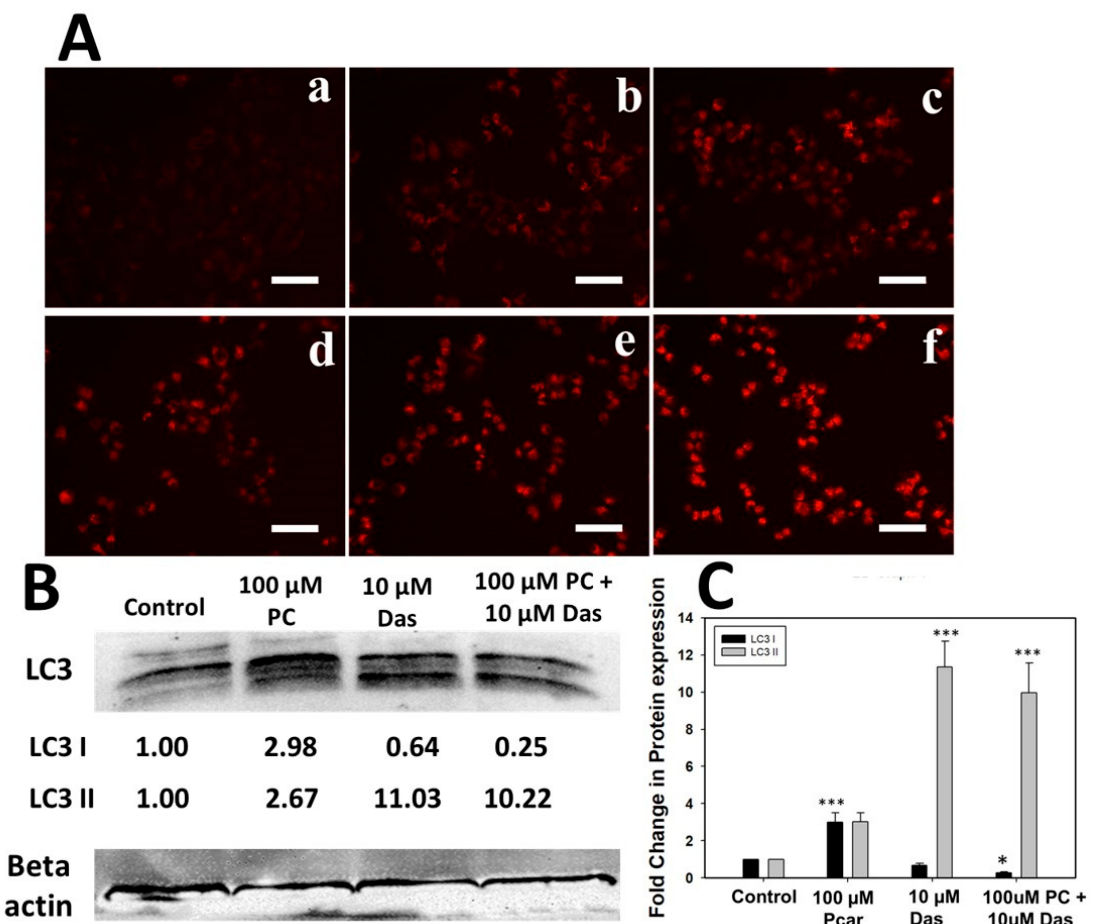
Figure 6. Lysotracker accumulation in HepG2 cells. ( A ) Pcar and Das combined effect showed more Lysotracker accumulation in lysosomes, thus confirming the autophagy induction. ( B ) Expression analysis of LC3 protein. ( a ) Control; ( b ) 100 µM Pcar; ( c , d ) 10 and 20 µM Das; ( e , f ) 100 µM Pcar + 10 and 20 µM Das. ( C ) Quantitative estimation of LC3 protein expression in control and treated cells. Scale bar 100 µm. Data represented as mean ± standard error (SE) obtained from three ( n = 3) different experiments * p < 0.05, *** p < 0.001. Scale bar 100 µm.